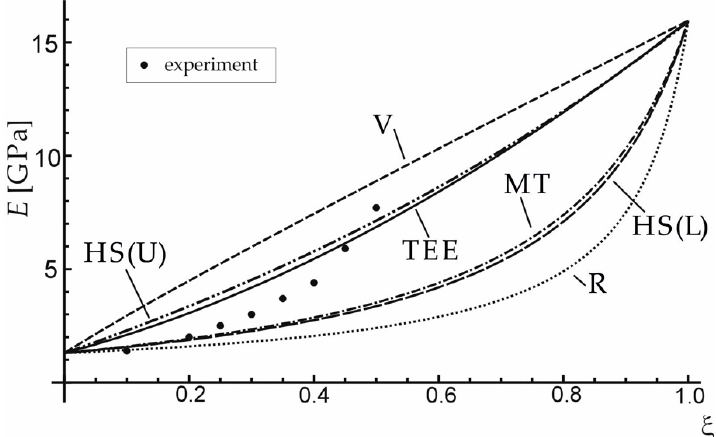
Figure 3. Comparison of effective Young’s modulus obtained with the use of the proposed method (TEE) and other approaches: V—Voigt, R—Reuss, MT—Mori-Tanaka, HS(U)—Hashin–Shtrikman Upper, HS(L)—Hashin–Shtrikman Lower for carbon short-fibre reinforced polyacetal.